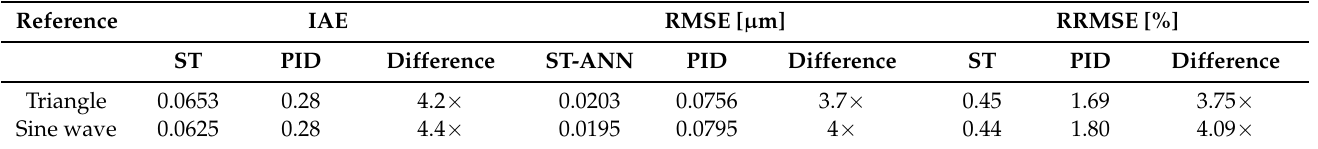
Table 4. Comparison of the different